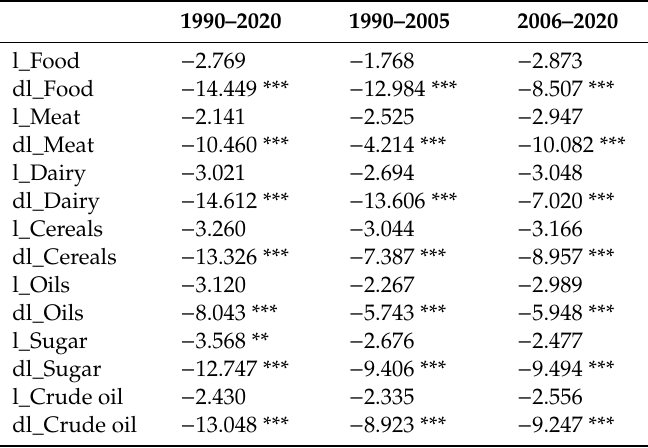
Table 3. Unit root testing